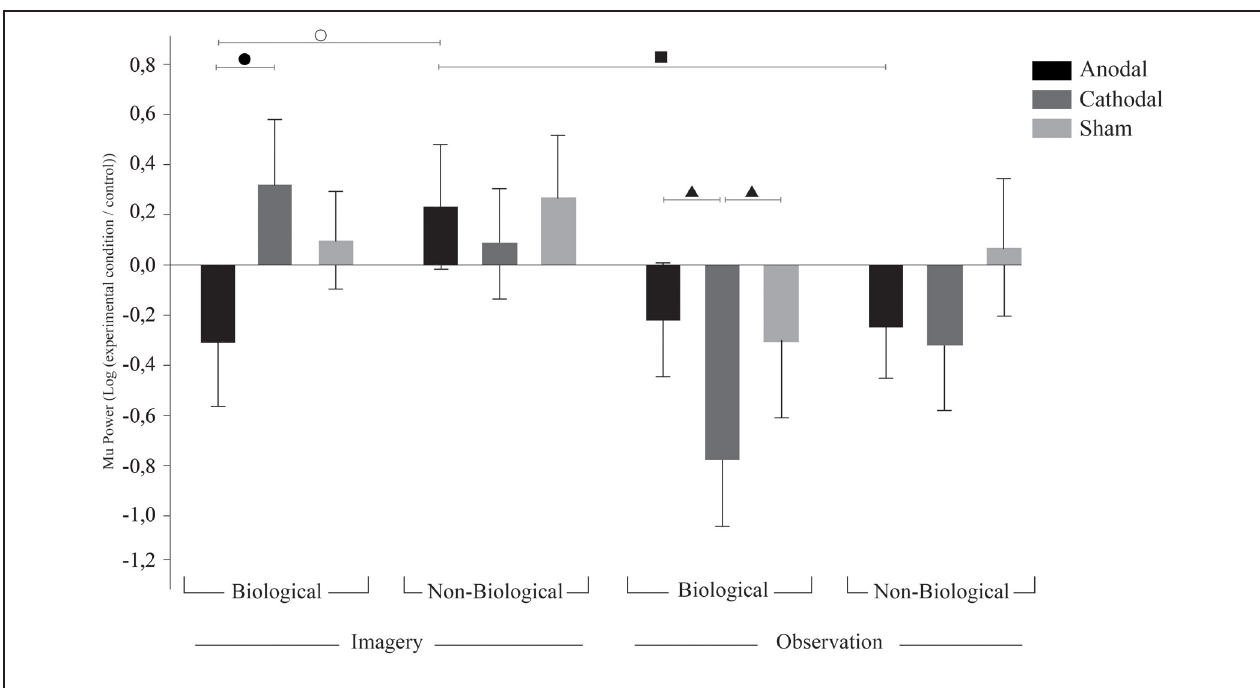
FIGURE 3 | TDCS effects on surrounding electrodes. Bars mean standard errors. (cid:3) , after anodal tDCS, biological imagery was significantly different from non-biological imagery ( p = 0 . 028); , anodal tDCS resulted in Mu ERD when compared to cathodal tDCS in biological imagery ( p = 0 . 011); ,